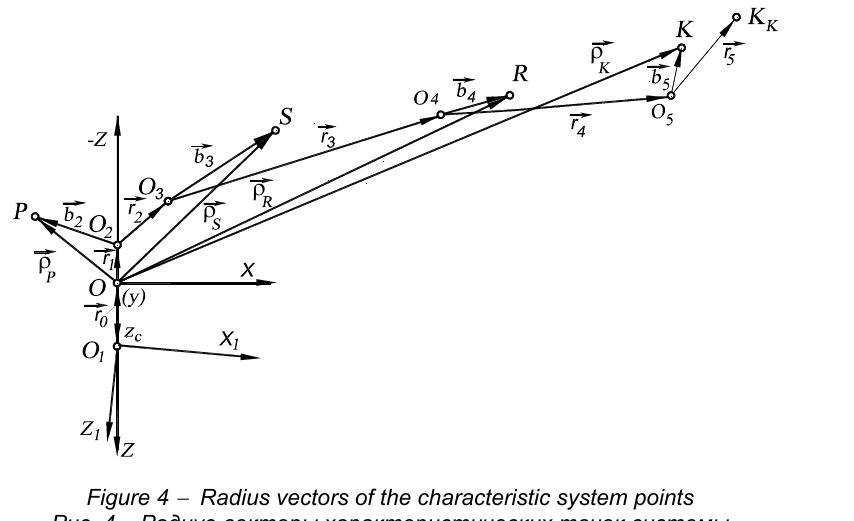
Figure 4  Radius vectors of the characteristic system points Рис . 4 – Радиус - векторы характеристических точек системы Слика 4  Радијус вектори карактеристичних тачака